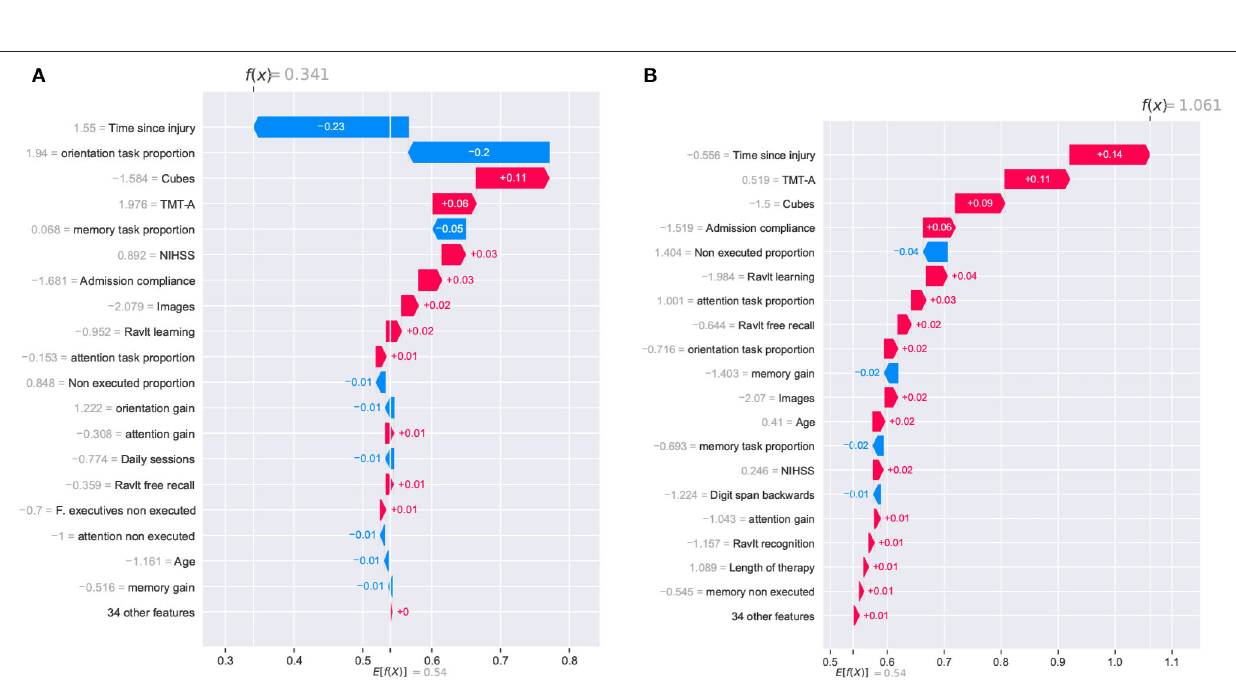
Frontiers in Neurology |